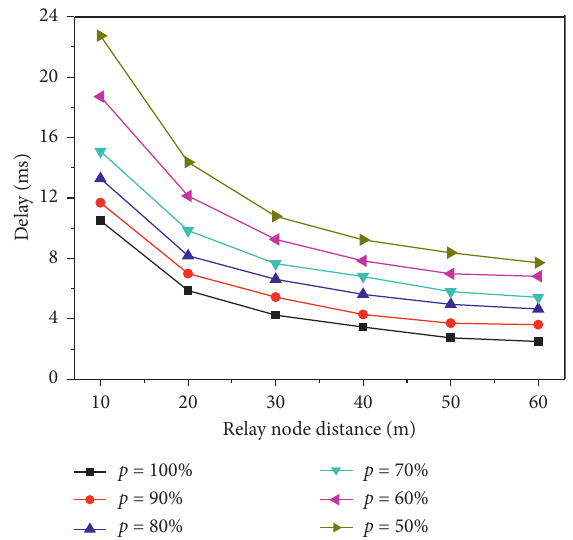
Figure 12: The transmission delay results under different suc- cessful transmission probability p when λ � 0.05.